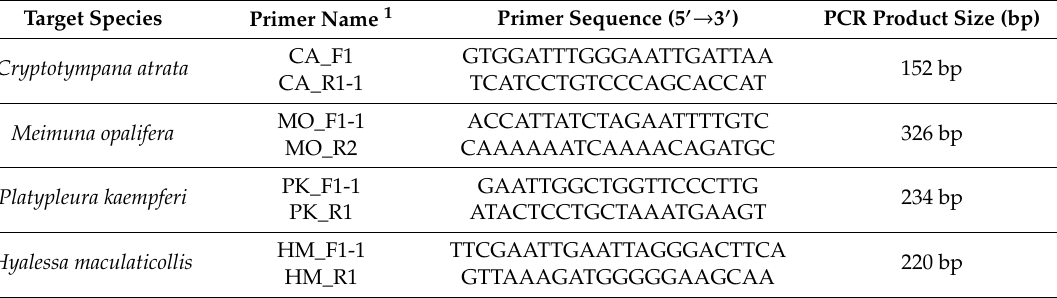
Table 2. Sequences of sequence-characterized amplified-region (SCAR) primers and product